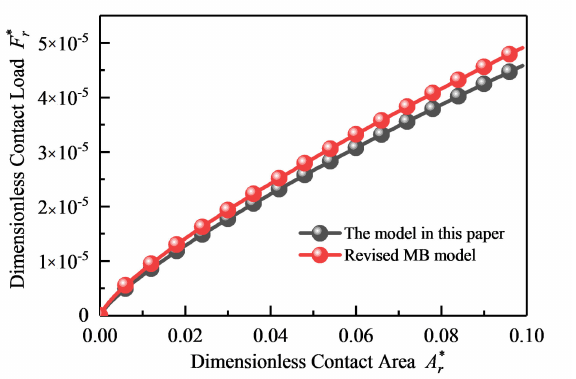
Figure 11. Comparison of the mechanical properties between the model in this paper and the MB contact model.